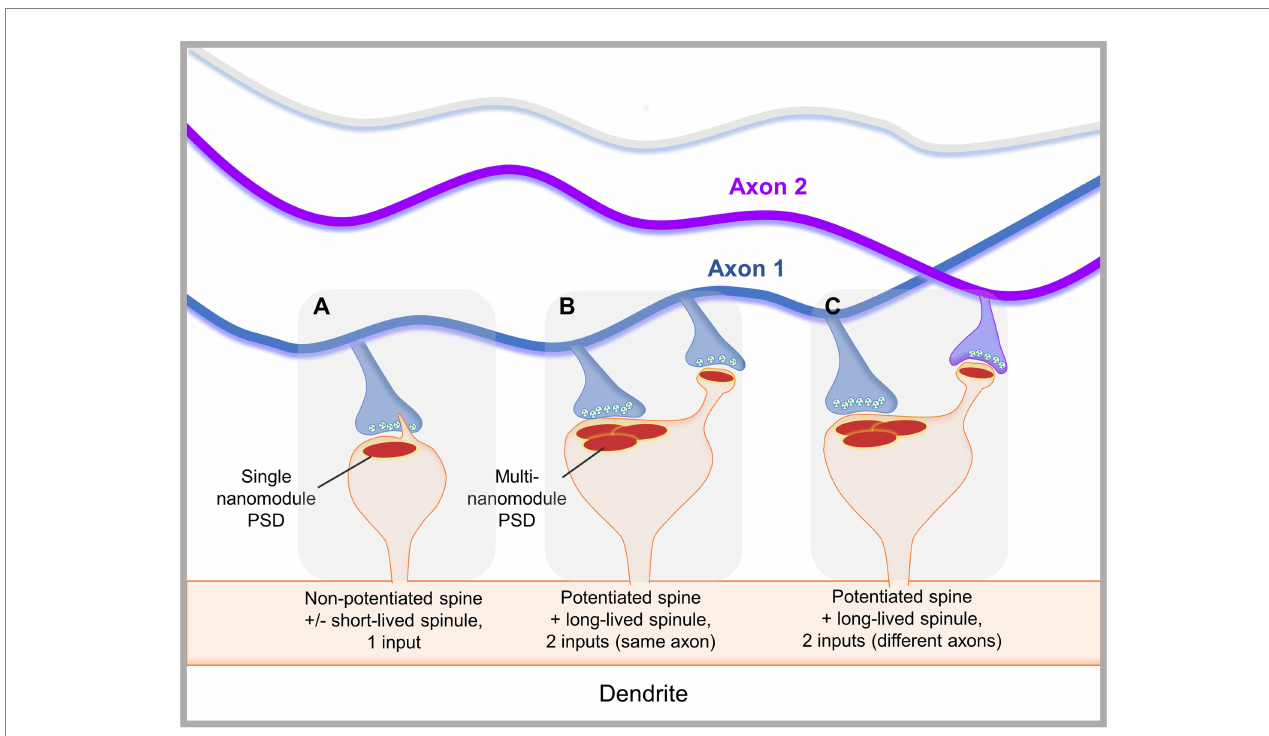
FIGURE 2 Proposed functions of spinules in mediating localized structural synaptic plasticity. (A) A smaller, non-potentiated spine with a simple PSD occasionally forms small, dynamic short-lived spinules, which emerge from close to the PSD edge. Small spinules may be trans-endocytosed or explore their environment. (B) A large, potentiated spine displays a complex PSD, with multiple nanomodules, and an elongated long-lived spinule. The spinule forms a secondary synaptic connection with a bouton from the same axon as the one forming a synapse with the spine head. (C) A large, potentiated spine with multiple PSD nanomodules displays a long-lived spinule that contacts an adjacent bouton originating from a different axon than the one synapsing with the spine head. These interactions may facilitate secondary synapse formation, potentially leading to alterations in synaptic plasticity, connectivity, and down- stream brain